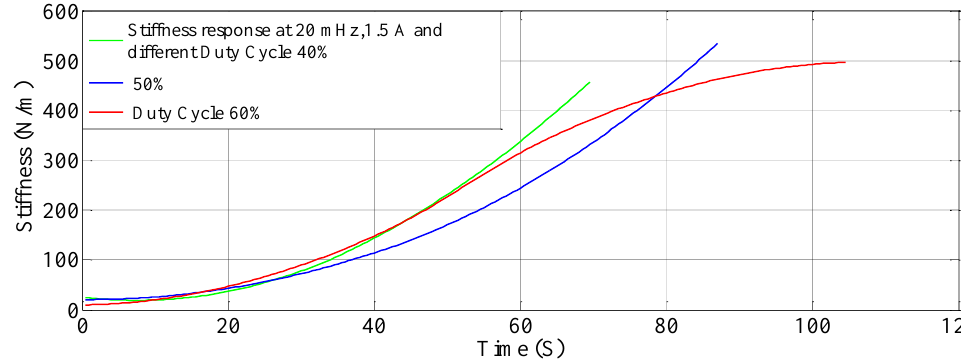
Figure 16. Resistance response at different duty cycles.